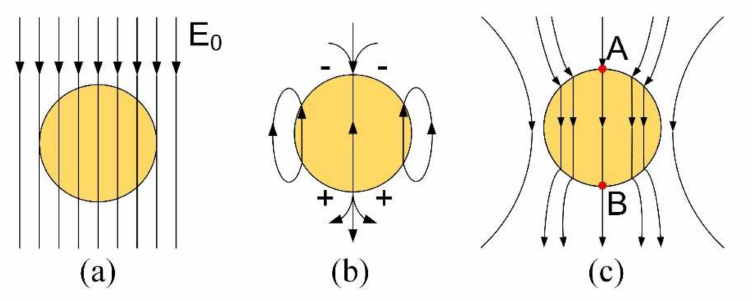
Figure 2. Illustration of electric fields: ( a ) uniform electric field, ( b ) electric field of the bound charge, ( c ) superimposed electric